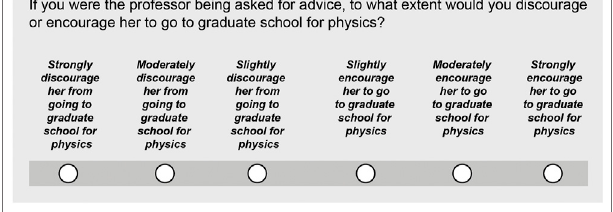
Frontiers in Sociology |